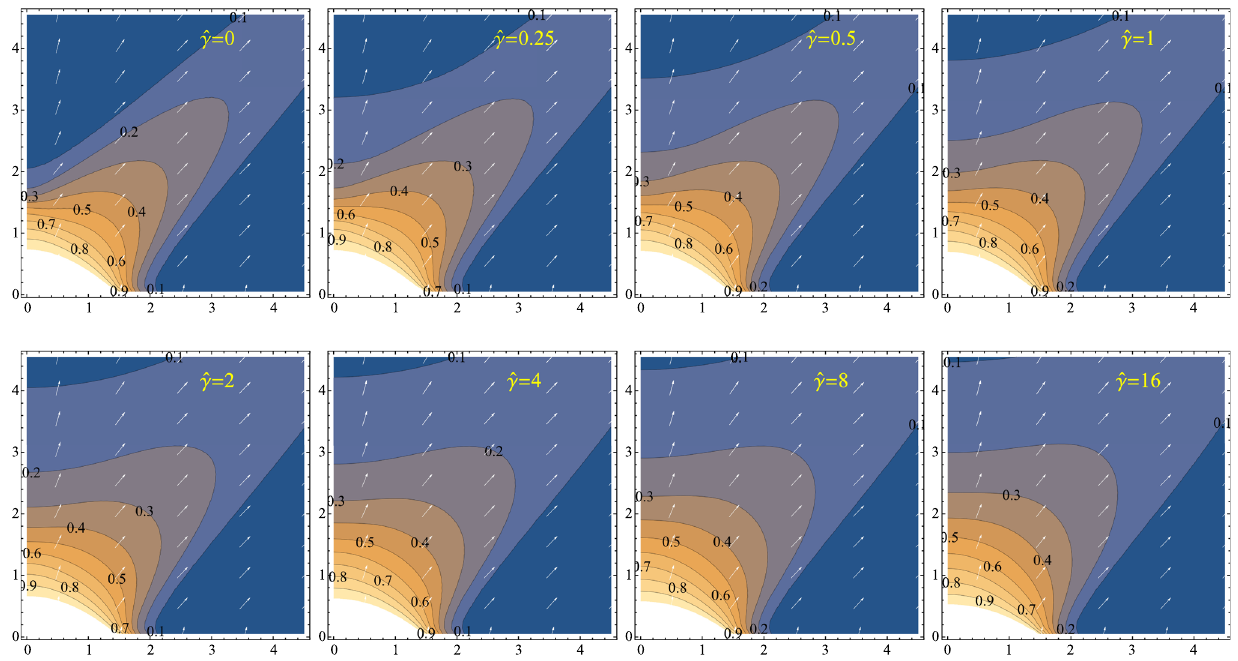
to realize almost perfect fluid dynamic behavior. The contours depict isotherms, with ε 1 / 4 decreasing from one isothermal to the next by 10% of its value along the innermost contour. White arrows denote the direction u μ = ( u τ , u r , 0 , 0 ) of the radial flow field